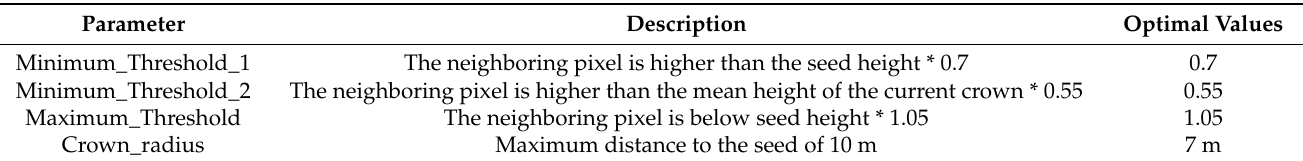
Table A2. The Pycrown parameter description and settings for the segmentation algorithm.